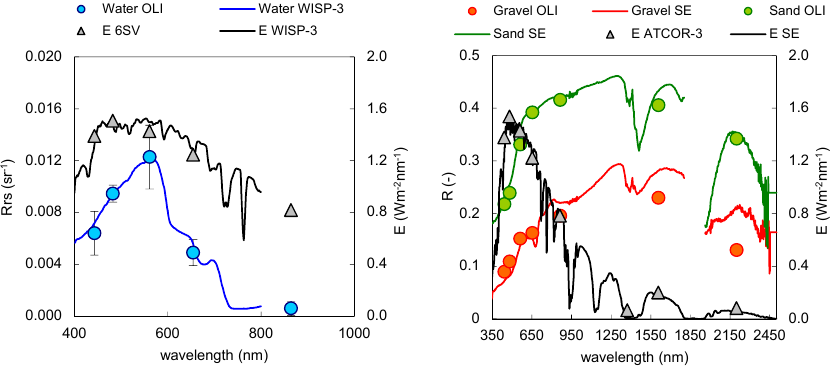
Figure 3. Comparison of in situ (continuous lines) and OLI derived spectra (dots) for water and terrestrial targets. On left, WISP-3 Rrs values (sr − 1 units) are plotted with the 6SV-derived reflectances divided by π . On right, SE reflectances R (dimensionless) of sandy and gravel beaches are compared with those provided by ATCOR-3. On the secondary y-axis, both plots show the irradiance values E at the time of image acquisition measured in situ (continuous line) and estimated running the atmospheric correction codes (triangles).